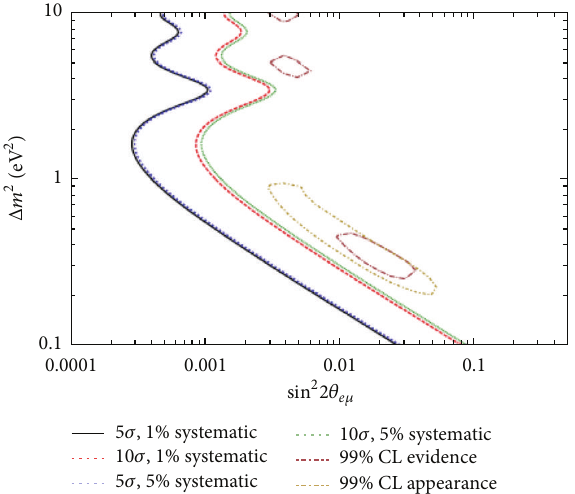
Figure19:NuSTORMcancovertheallowedLSNDandMiniBooNE oscillation regions at the 10𝜎 level (from